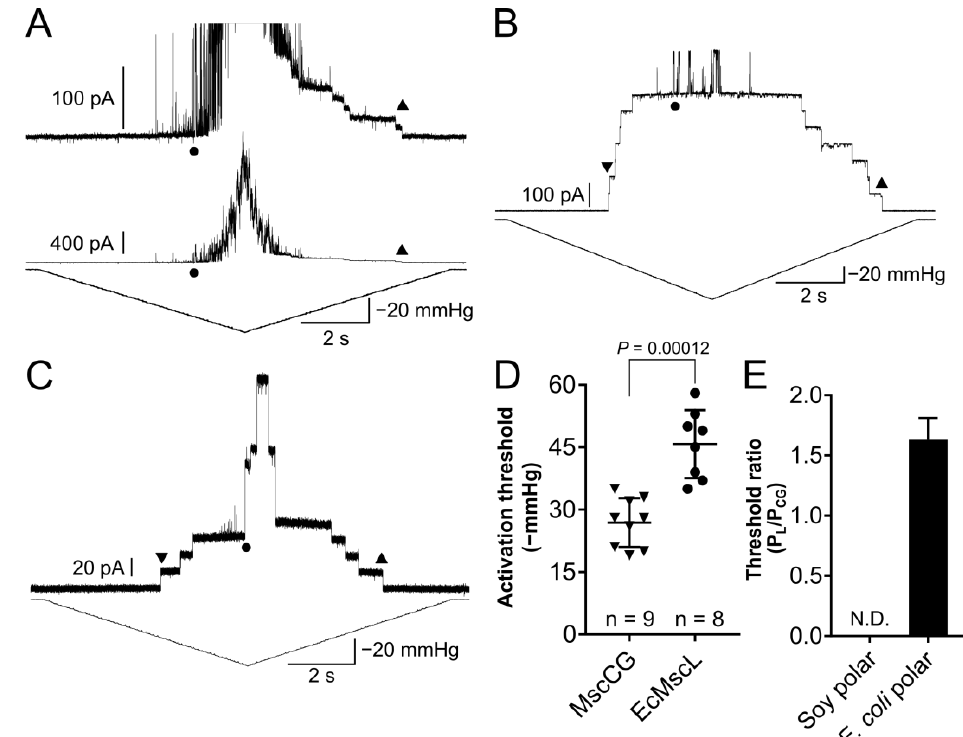
Figure 4. Mechanosensitivity of MscCG and co-reconstituted EcMscL in soy and E. coli polar extract liposomes. ( A ) Current recordings of MscCG and EcMscL co-reconstituted in soy polar extract liposomes. Circles show the first opening of EcMscL, and upward triangles show the last closing of MscCG. A zoomed current trace is for small MscCG currents (top), and an entire trace is for large EcMscL currents (bottom). ( B ) Current recordings of canonical E. coli MscS and EcMscL co-reconstituted in soy polar extract liposomes. Circle shows the first opening of EcMscL. Downward and upward triangles show the first opening and the last closing of MscS, respectively. ( C ) Current recordings of MscCG and EcMscL co-reconstituted in E. coli polar extract liposomes. Downward and upward triangles show the first opening and the last closing of MscCG, respectively. Circle shows the first opening of EcMscL. ( D ) First opening activation threshold of MscCG and EcMscL in liposomes made of E. coli polar lipid extract. Downward triangles show the first opening threshold of MscCG. Circles show the first opening threshold of EcMscL obtained from multiple experiments in (C). ( E ) First opening threshold ratio between EcMscL and MscCG (P L /P CG ) in liposomes made of E. coli polar lipid extract. p -values were calculated by t -test (two-sample assuming unequal variances) to compare between two groups.